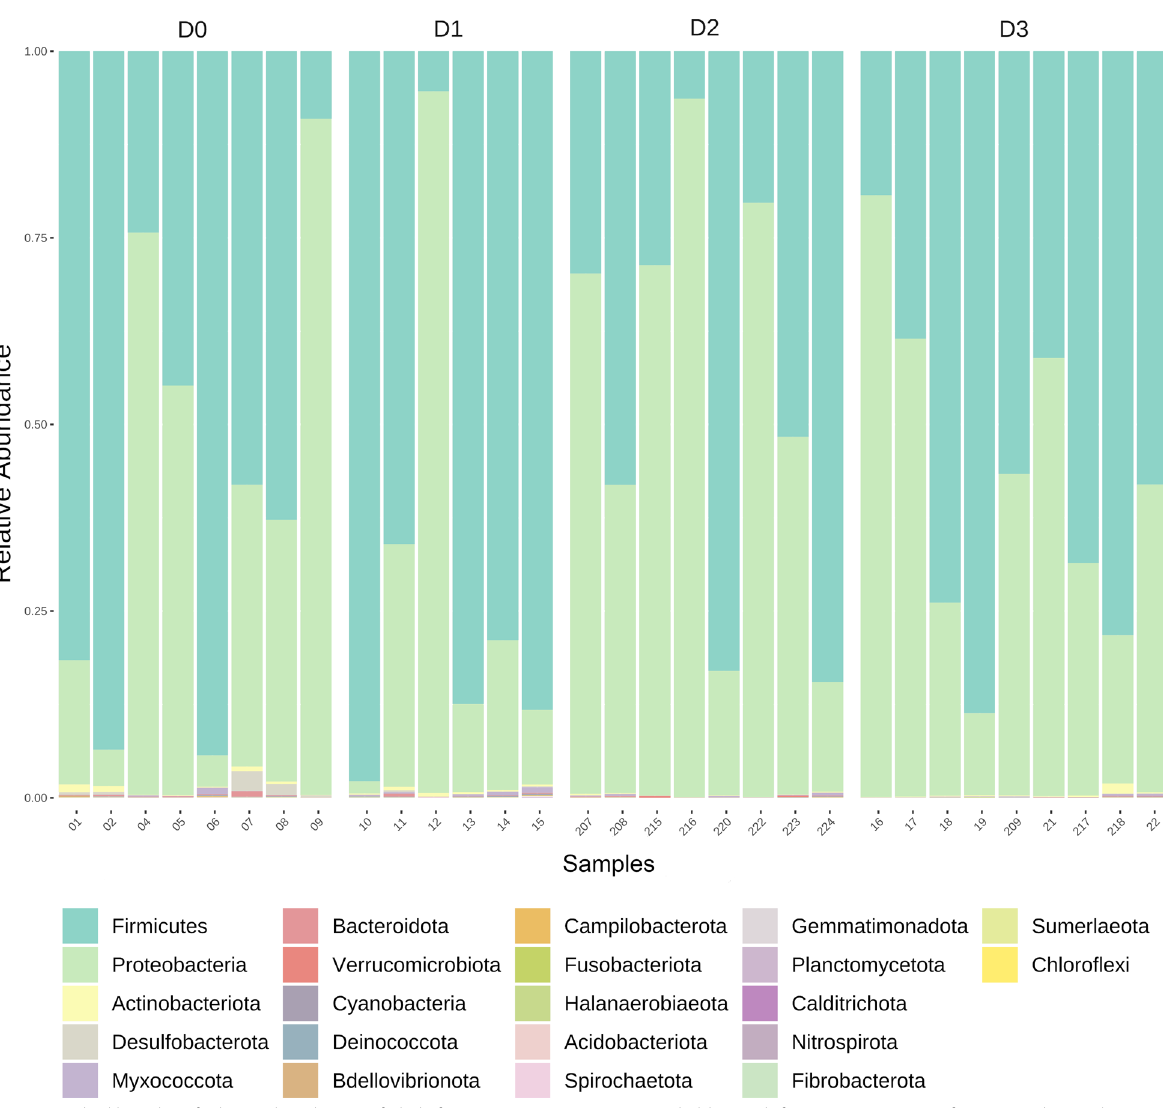
Fig. 1 Stacked bar plot of relative abundances of phyla from scenarios D0 (mature and old growth forest), D1 (extensive farming and agriculture), D2 (immature and secondary forest), and D3 (urban and intensive agriculture). Fecal samples are displayed on the bottom and scenarios displayed at the